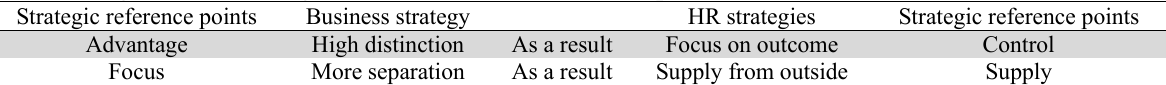
Basis of alignment in strategies based on distinction and separation Strategic reference points Business strategy HR strategies Strategic reference points Advantage High distinction As a result Focus on outcome Control Focus More separation As a result Supply from outside